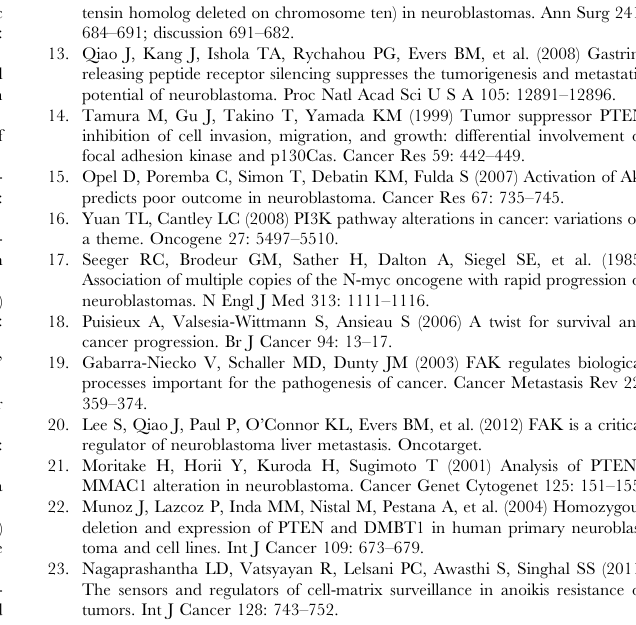
Figure S1 Doxycycline treatment induced GRP silencing in neuroblastoma cell lines. (A) Semi-quantitative analysis of GRP mRNA levels confirmed silencing after doxycycline treatment for 48 h in BE (2)-C/Tet/shGRP and SH-SY-5Y/Tet/shGRP. (B) Real-time PCR demonstrated significant silencing of GRP mRNA levels after doxycycline treatment for 48 h in BE (2)-C/ Tet/shGRP and SH-SY5Y/Tet/shGRP (mean 6 SEM; *= p , 0.05 vs. without